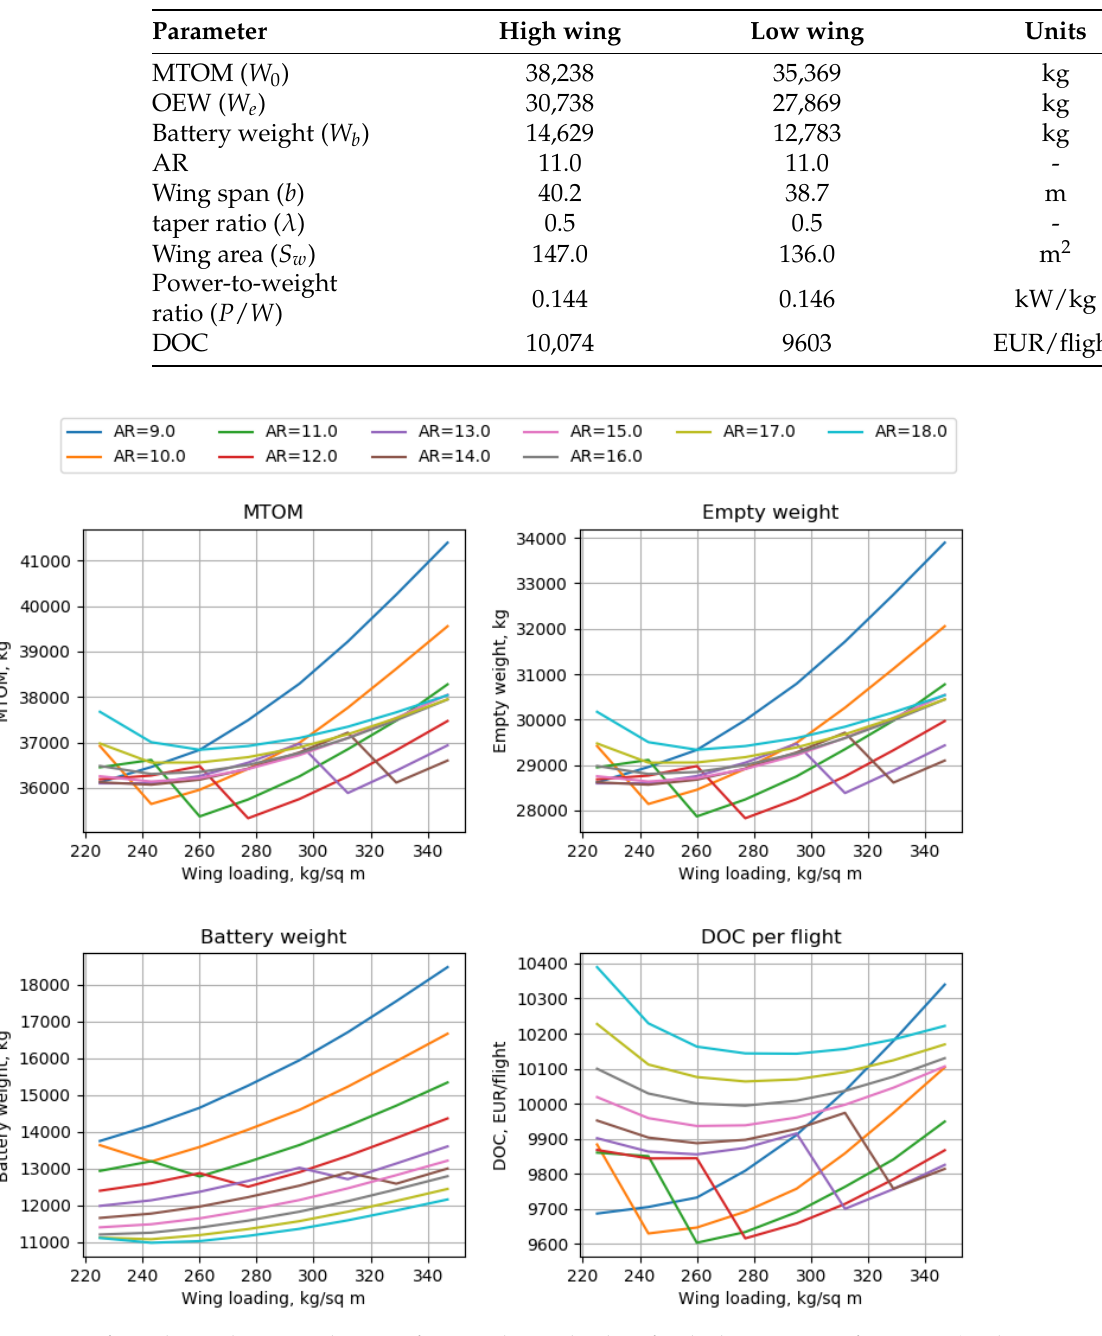
Table 3. Comparison between the high-wing and low-wing concepts.